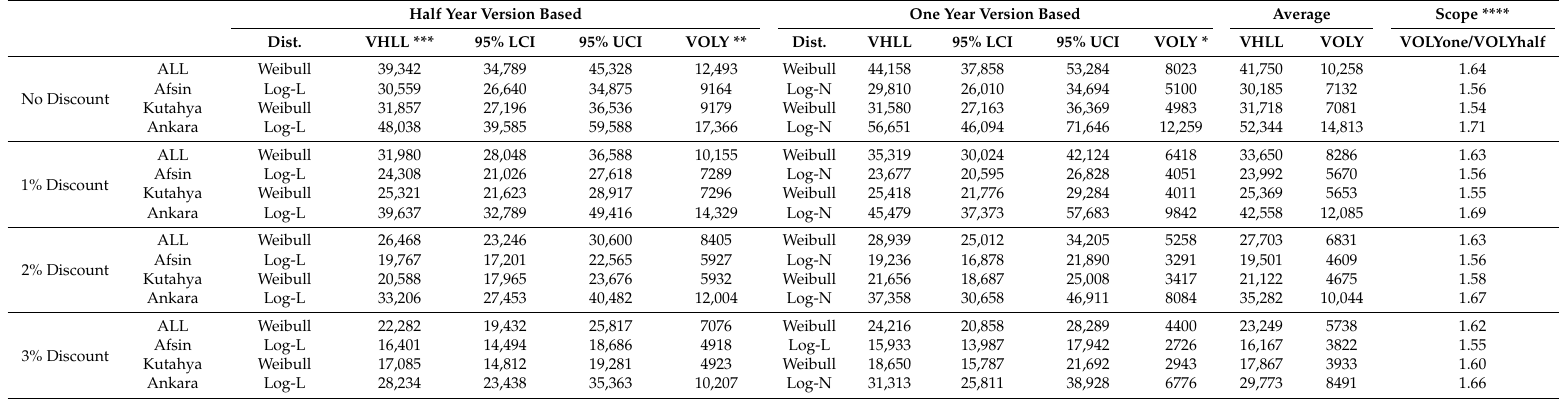
Table 7. Estimated results of discounted VHLL and